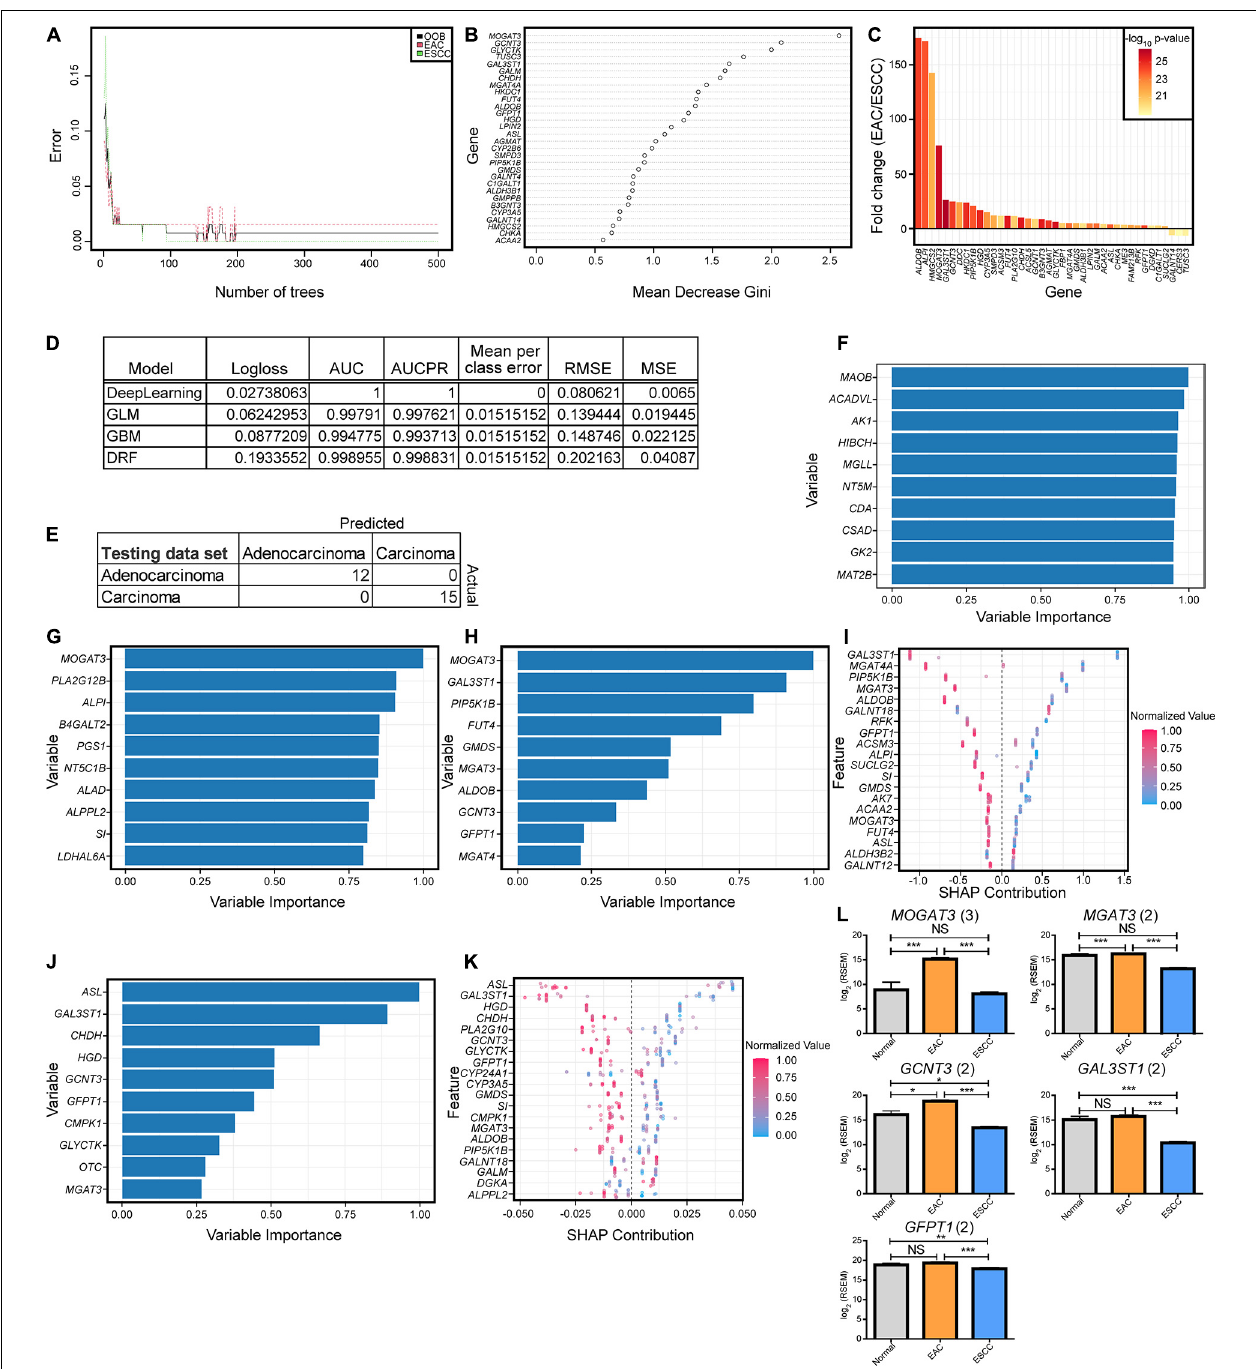
FIGURE 2 | Key enzymatic markers between histological subtypes. (A) Random forest error rate with increasing number of trees when differentiating subtypes based on enzymes. (B) Random forest variable importance from 500 trees. (C) The fold change log 2 mRNA expression and -log 10 p -values generated from a Mann–Whitney U test for the optimal enzymes discovered from the sparse partial least-squares discriminant analysis (sPLS-DA) in Figure 1 . (D) Machine modules with hyperparameter tuning trained on enzyme expression with the best logloss model being reported for each category, when applicable. Abbreviations are as follows: AUC, area under the curve; AUCPR, area under the precision-recall curve; RMSE, root mean square error; MSE, mean square error. (E) All of the models resulted in the same confusion matrix with the same holdout dataset. (F–K) Variable importance is seen for each of the top tuned models, including deep learning based on a feedforward neural net (F) , generalized linear model (G) , gradient boosting machine (H,I) , and distributed random forest (J,K) . Enzymes reported multiple times in the top 10 for importance in panels (F–H) and (J) had the expression plotted between the subtypes, with the number in parentheses indicating the number of occurrences (L) . Error bars represent the standard error of the mean. Statistics were calculated through Mann–Whitney U test. NS, not significant, * p < 0.05, ** p < 0.01, *** p < 0.001.